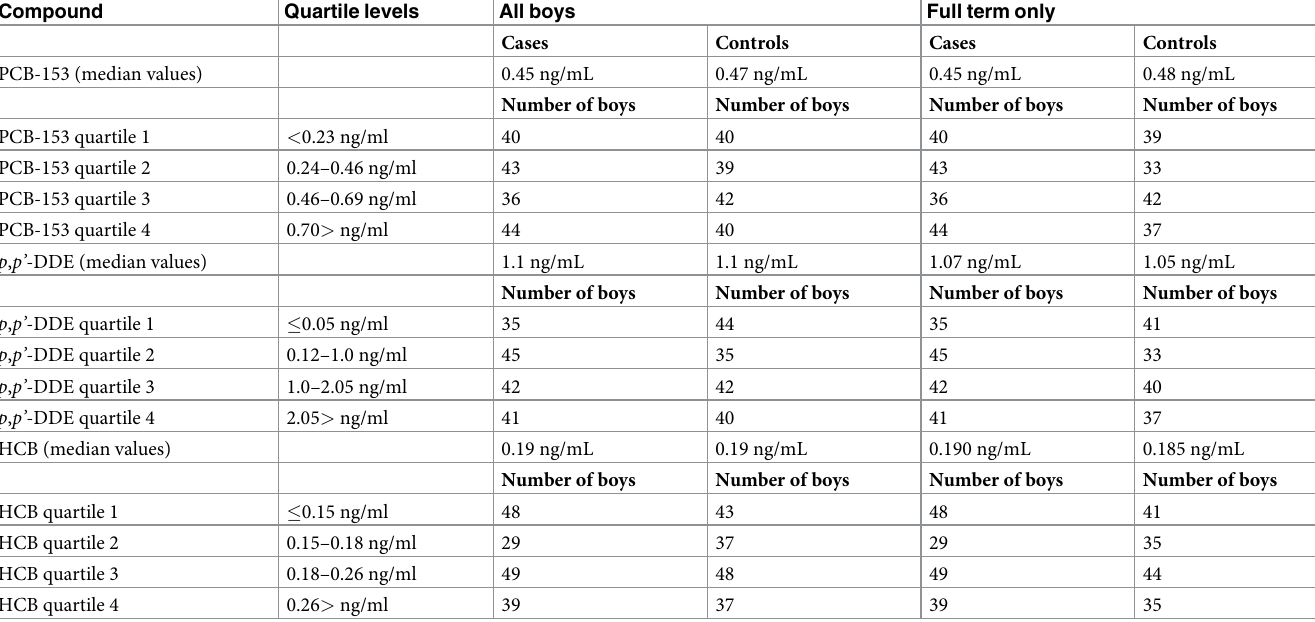
Table 2. Maternal serum concentrations of (and quartiles of exposure to) PCB-153 (n = 324), p , p’ -DDE (n = 324) and HCB (n = 330) during pregnancy in cases of cryptorchidism and matched controls, as shown in all boys (n = 330) and those only born full term (n = 320). Compound